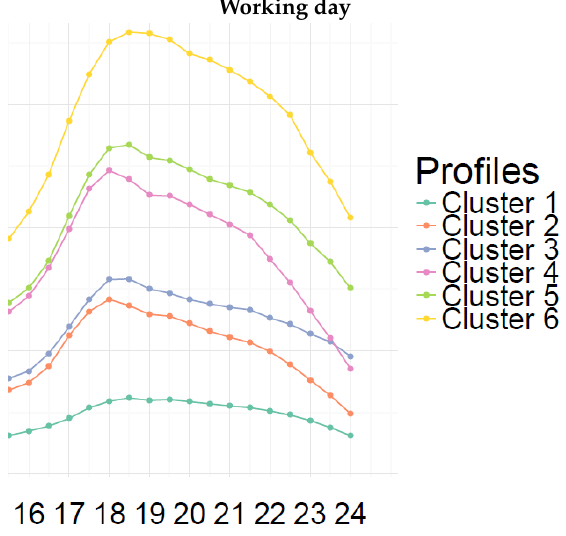
Figure 4. Close-up of the electricity consumption profiles without normalization during the working